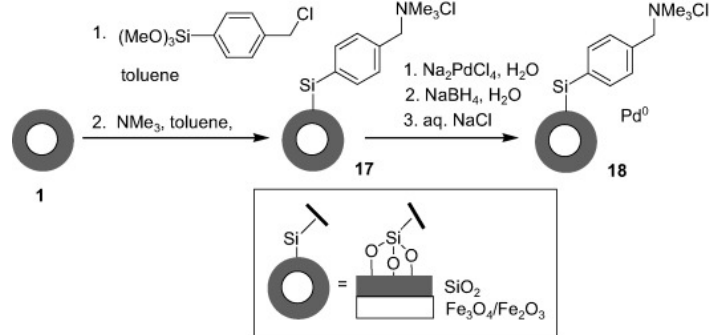
Figure 5. Preparation of Pd 0 functionalized magnetic nanoparticles [54].